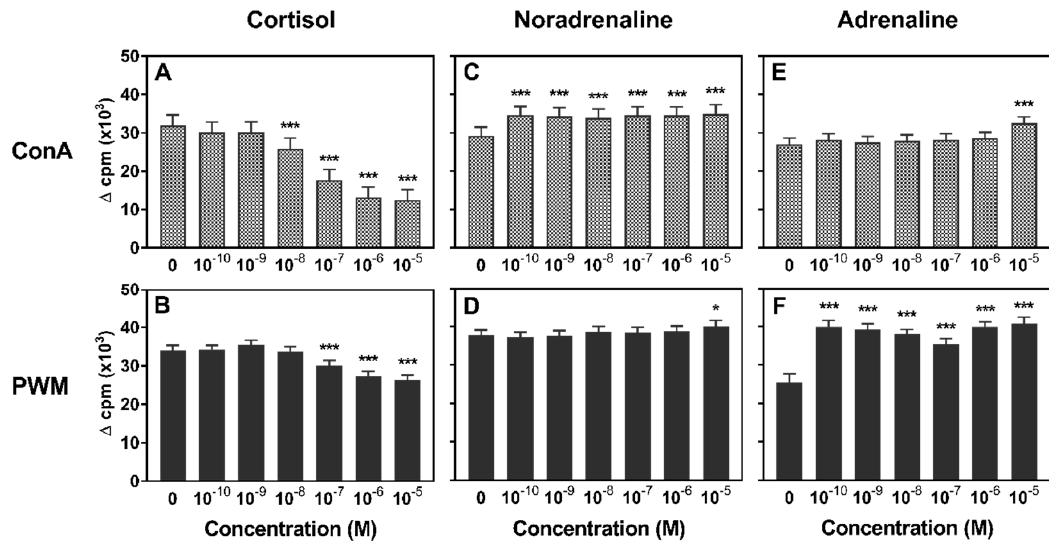
Figure 1. Lymphocyte proliferation after incubation with cortisol ( A , B ), noradrenaline ( C , D ) or adrenaline ( E , F ) (10 − 10 –10 − 5 M) and one of the mitogens concanavalin A (ConA) ( A , C , E ) or pokeweed mitogen (PWM) ( B , D , F ) in vitro ( n = 20). Data are presented as lsmeans + standard error of the mean (SEM) of ∆ cpm (counts per minute) of the untransformed data. Asterisks indicate significant di ff erences between treatment and hormone-free control (0): * p ≤ 0.05; *** p < 0.001.